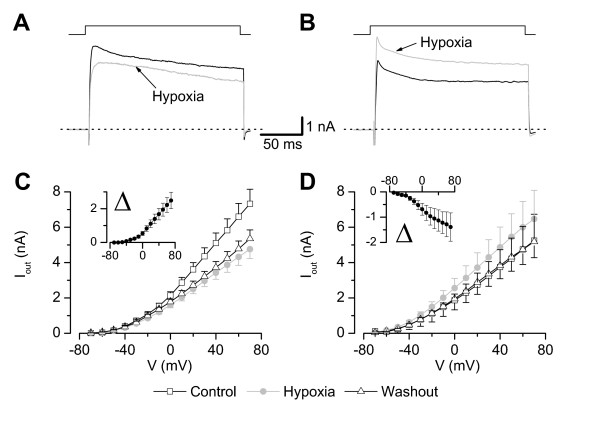
Moderate hypoxia effects outward currents differently. A, B) Current recordings (holding potential -80 mV, step to +40 mV) of neurones showing either decreased (A) or increased (B) whole-cell outward currents in hypoxic Ringer's solution. C, D) Current-voltage relation of neurones with reduced outward currents (C, 77% of neurones) or increased outward currents (D, 23% of neurones) in hypoxia. The insets show the I-V relation for the difference currents between control and hypoxia (C). Data represent mean ± S.E.M., pipette: High-Ki EGTA, n = 23.